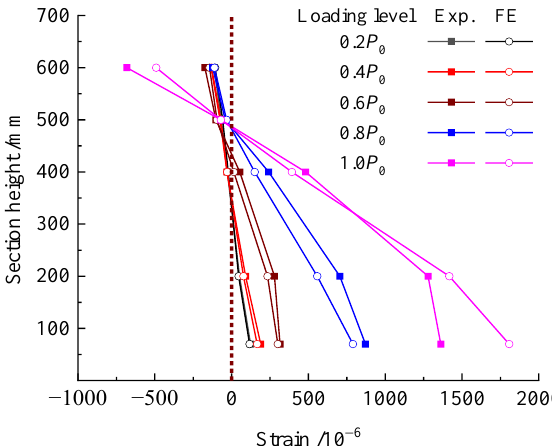
Figure 10. Concrete strain at mid-span section of the repaired beam at different loading level.